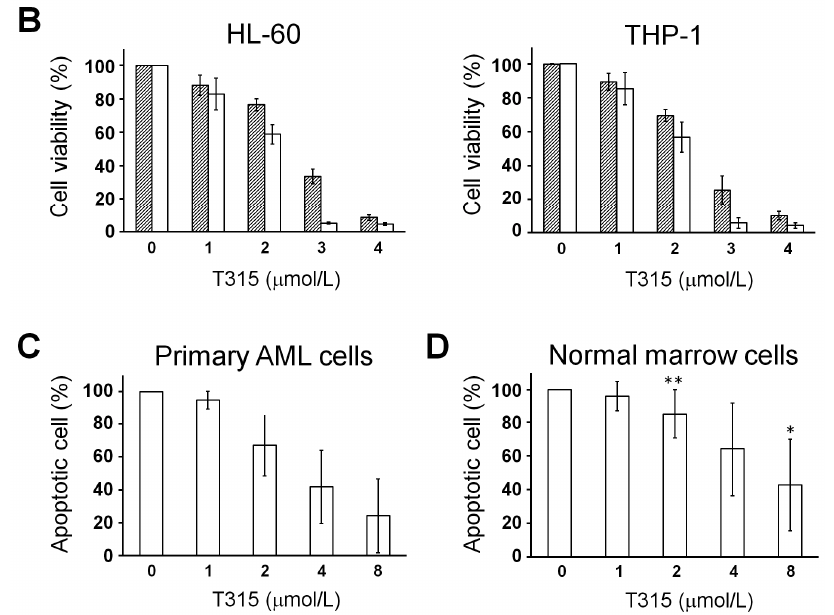
Figure 1. Cell viability inhibition study of T315 in acute myeloid leukemia (AML) cell lines, primary AML cells and normal marrow cells. ( A ) HL-60 and THP-1 cells (0.25 × 10 6 cells/mL) were incubated with T315 or dimethyl sulfoxide (DMSO) vehicle for 24 h. The apoptotic cells were analyzed by annexin V-FITC and propidium iodide (PI) staining, as described in Materials and Methods. Upper panel: one example; Lower panel: apoptotic cell percentage ( n = 3); ( B ) HL-60 and THP-1 cells (0.25 × 10 6 cells/mL) were incubated with T315 or DMSO vehicle for 24 h ( ) or 48 h ( □ ). The cells were analyzed by MTS assay, as described in Materials and Methods; ( C ) Primary AML cells (0.25 × 10 6 cells/mL) were incubated with T315 or DMSO for 24 h. The cells were stained with annexin V-FITC and PI to assess apoptotic cells percentage ( n = 26); ( D ) Normal bone marrow nucleated cells (0.25 × 10 6 cells/mL) were incubated with T315 or DMSO for 24 h. The cells were stained with annexin V-FITC and PI to assess apoptotic cells percentage ( n = 16). * denotes p < 0.05; ** denotes p < 0.01 compared to the control group (in panel A ) or compared to the primary AML cells at the same concentration of T315 (in panel D ).